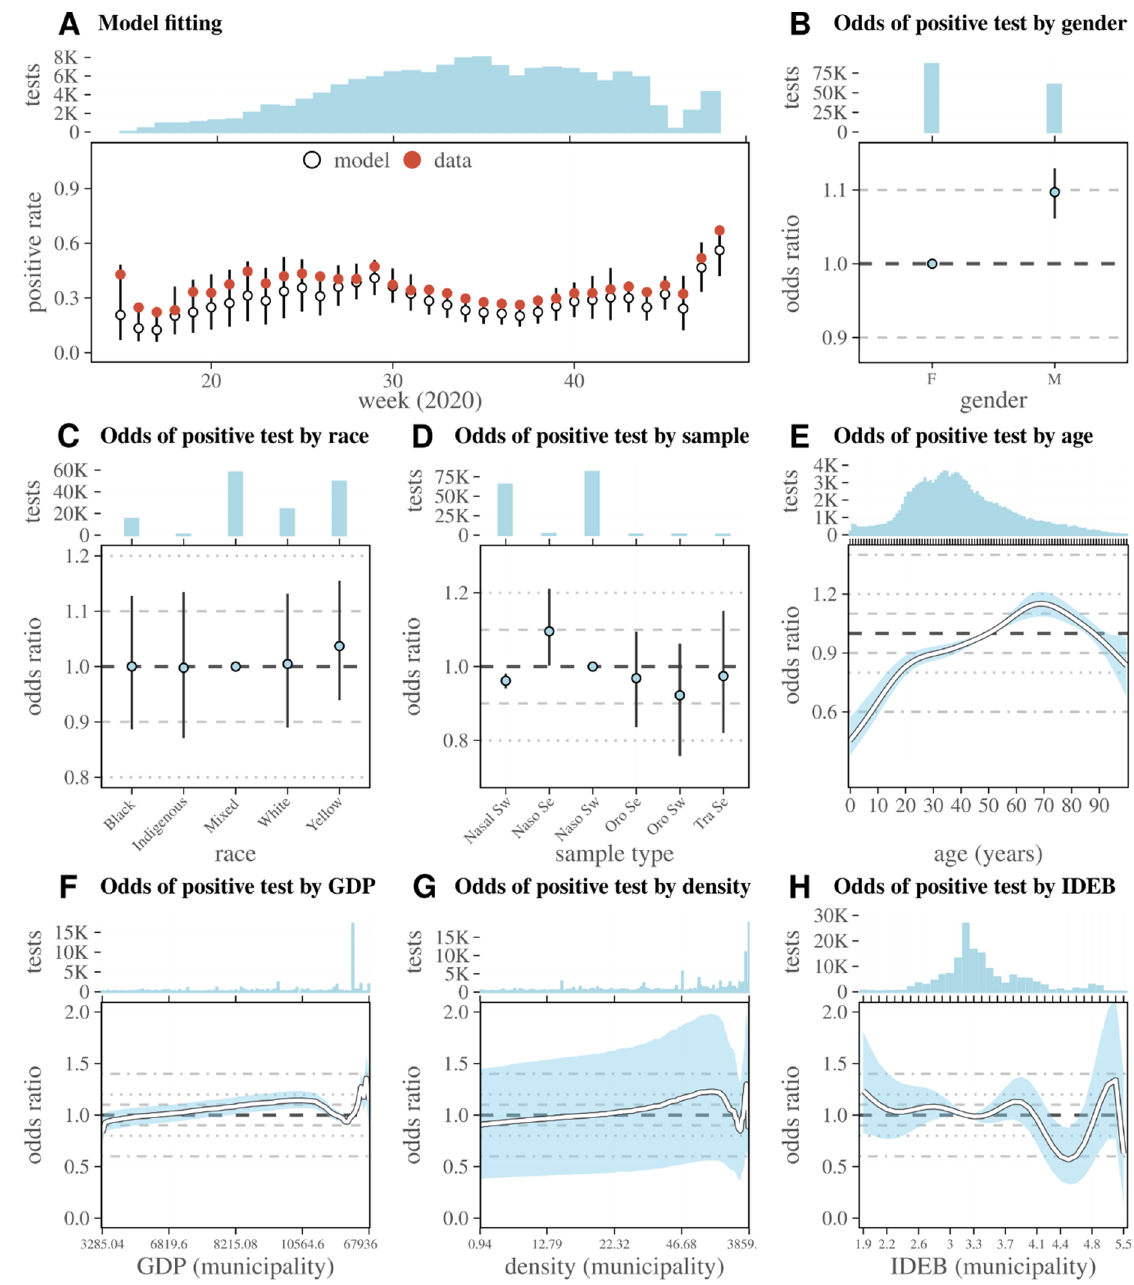
Figure 4. SARS-CoV-2 positive rate and odds ratio for a positive test dependent on other variables (laboratory LCDSPPGM). ( A ) Model fit to positive rate per week, with model in white full circles and data in red full circles. ( B – H ) Odds ratio of a positive test depending on ( B ) gender, ( C ) race, ( D ) sample type, ( E ) age, ( F ) GDP, ( G ) density, and ( F ) IDEB of the patient’s municipality. ( A – H ) Top subpanel presents the total tests per variable value/category on the x-axis (the K in the y-axis refers to thousands). Values of reference (odds = 1) are the mode of each variable except for age, for which the reference was 50 years. Points (discrete variables) and lines (continuous variables) are the mean odds, and the whiskers and areas are the 95% percentile. ( D ) Sample type key: “Naso Sw” = nasopharyngeal swab, “Oro Se” = oropharyngeal secretion, “Naso Se” = nasopharyngeal secretion, “Oro Sw” = oropharyngeal swab, “Tra Se” = tracheal secretion, “Nasal Sw” = nasal swab. The presented fit was extracted from the GAM model by setting the variable laboratory to LCDSPPGM; for other laboratories, see Supplementary Figures S7–S14. Variables presented are the statistically sig- nificant ones (see Model 1 in Supplementary Text S1 for details).